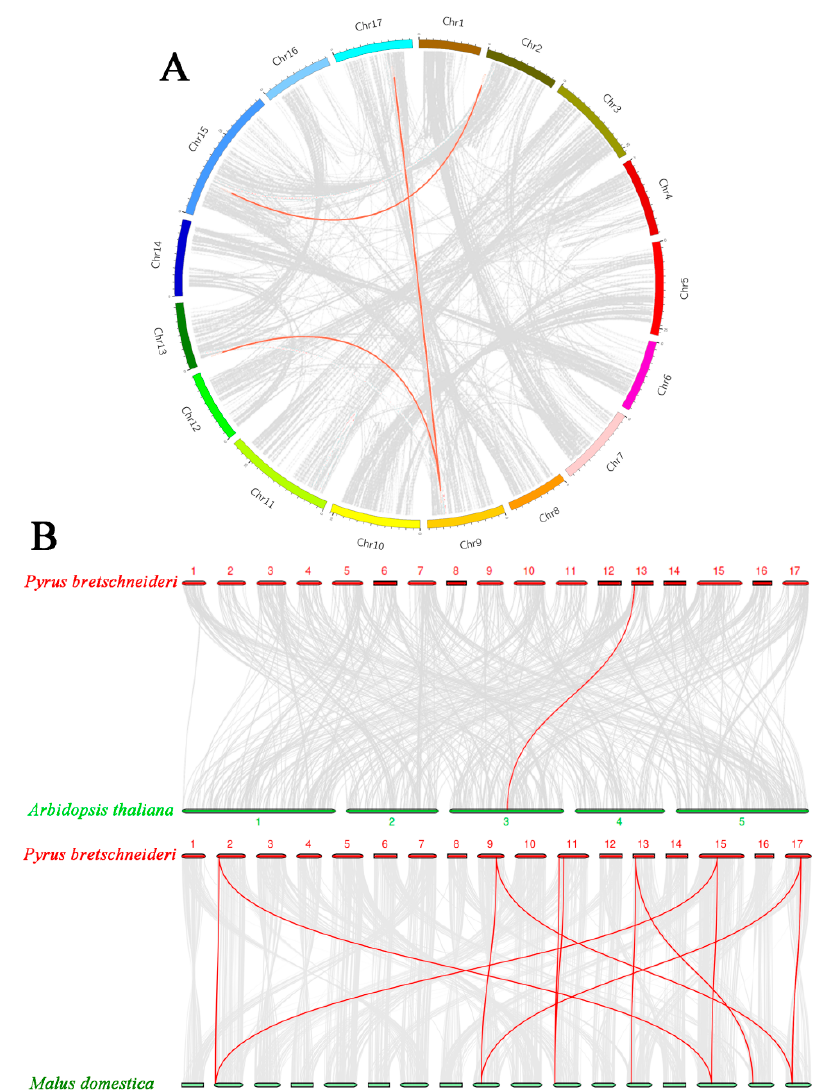
Figure 4. Collinearity of RAVs. ( A ) Distribution of segmentally duplicated PbRAV genes on P. bretschneideri chromosomes. Gray lines indicate collinear blocks in the whole P. bretschneideri genome and red lines indicate duplicated PbRAV gene pairs. ( B ) Collinearity of P. bretschneideri , Arabidopsis , and M. domestica RAV genes. Red lines indicate the syntenic gene pairs.